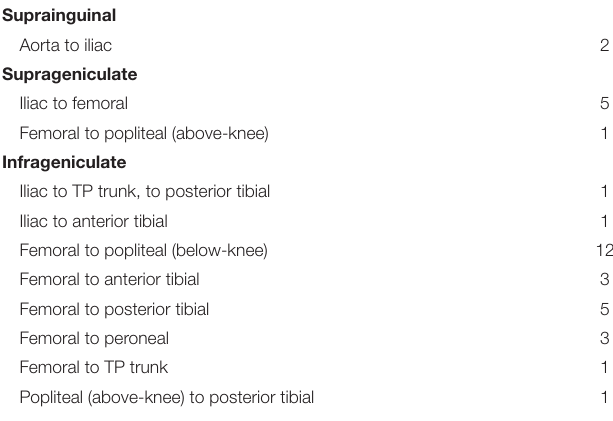
TABLE 2 | Allograft location regarding distal target